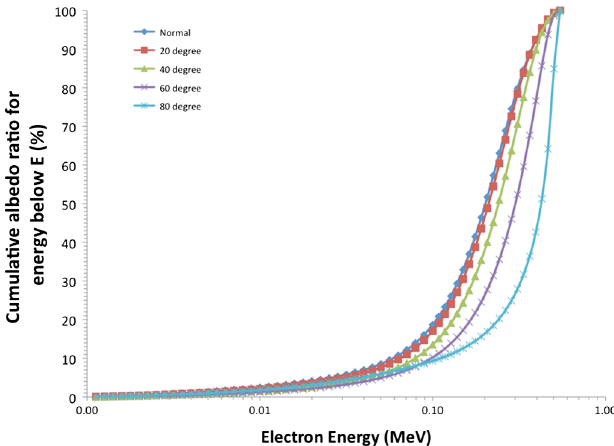
FIG. 7. Integrated probability distribution for outgoing beam energy for various incident beam angles and incident energy 560 keV.